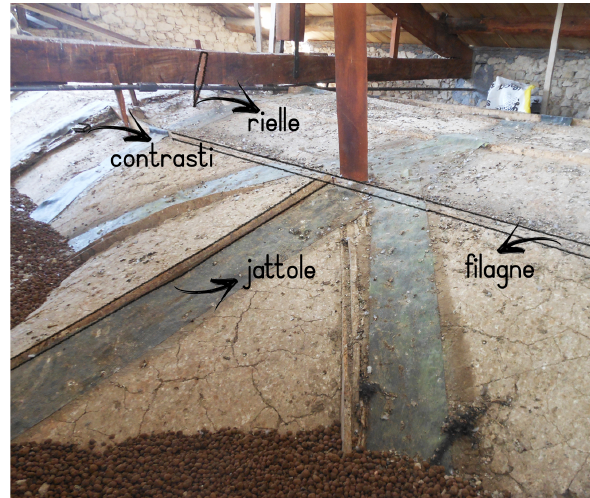
Figure 3. Baranello (Campobasso, Italy), Church of St. Michele Arcangelo: extrados of the wooden vault covering the central nave (Romano,